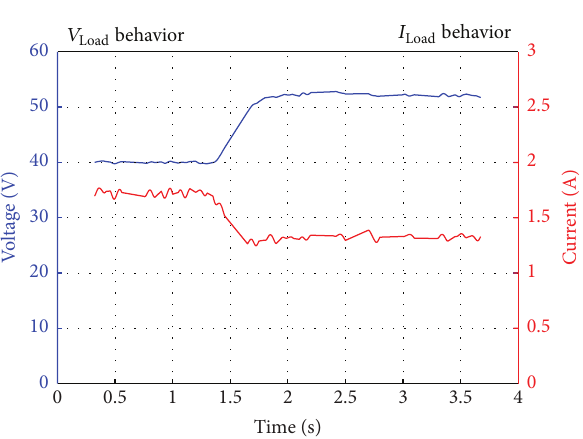
Figure 27: Behavior of load voltage 𝑉 Load and load current 𝐼 Load .